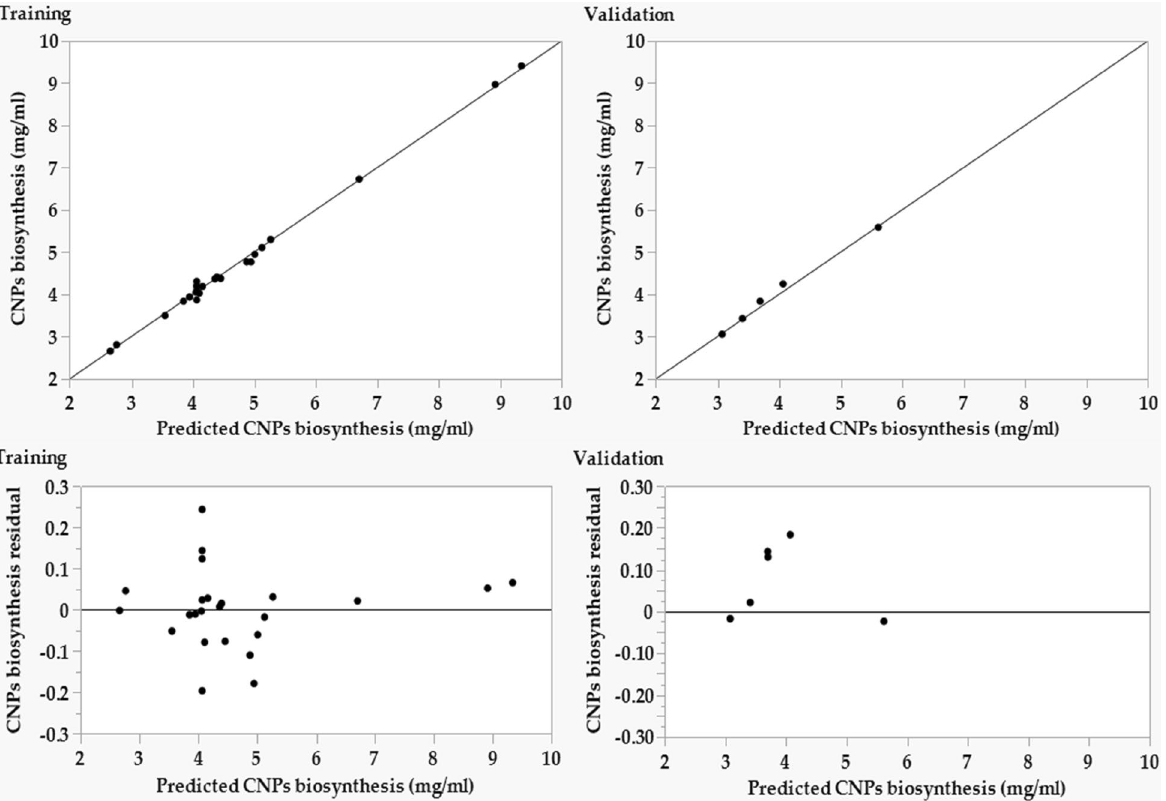
Figure 13. Chitosan nanoparticles biosynthesis versus the ANN predicted values and the residuals values using Streptomyces microflavus strain NEAE-83 for training and validation